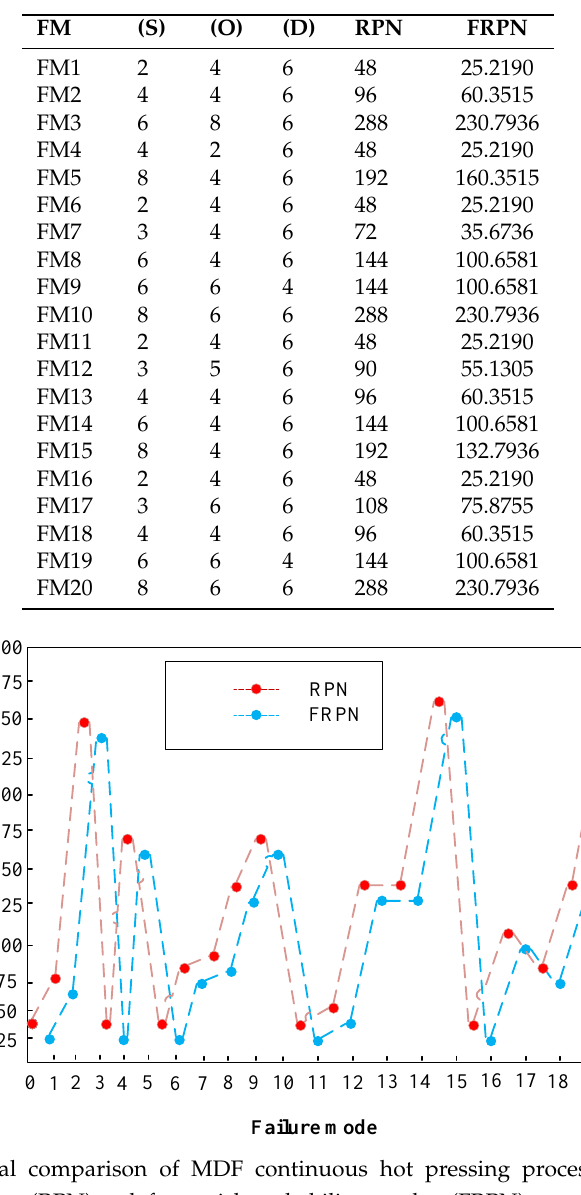
Table 2. The severity (S), degree of occurrence (O), and detectability (D) of the fuzzy scores of continuous hot pressing of MDF.